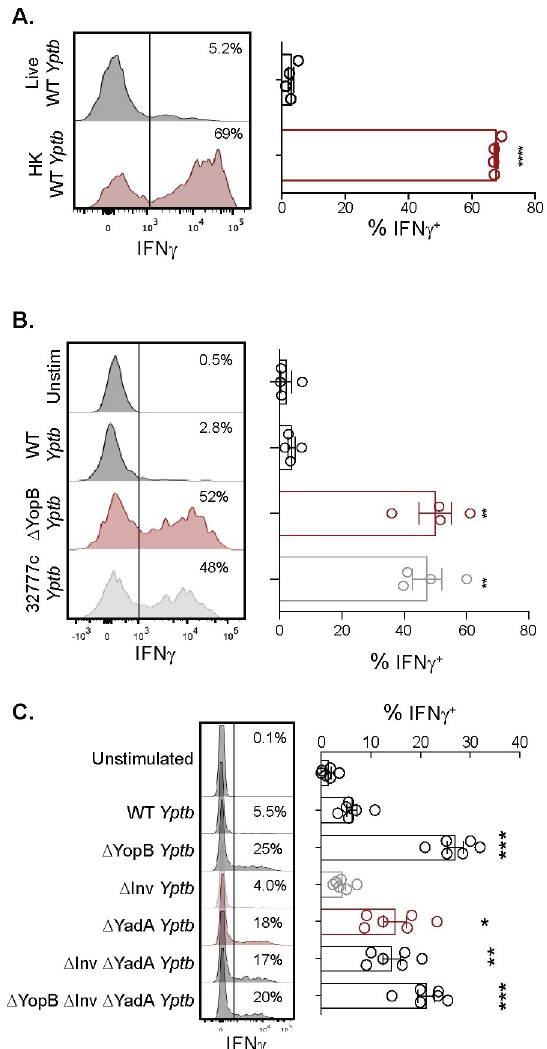
Fig 1. Y . pseudotuberculosis inhibition of V γ 1.1/2 - CD44 hi CD27 - γδ T cell function is YopB- and YadA- dependent. MLN cell suspensions from L . monocytogenes infected Balb/c mice were left unstimulated or stimulated with 10 MOI of the indicated Y . pseudotuberculosis for 24 hours. Antibiotics were given 2 hours post-stimulation and brefeldin A was added for the last 5 hours of stimulation. V γ 1.1/2 - CD44 hi CD27 - γδ T cells were analyzed for IFN γ production. Representative histograms are displayed. ( A ) Cells were stimulated with live or heat-killed (HK) wild-type (WT) Y . pseudotuberculosis . The graph depicts the mean ± SEM and represents at least two independent experiments with 4 mice/group/experiment. ( B ) Cells were stimulated with live WT, Δ YopB, or 32777c Y . pseudotuberculosis . The graph depicts the mean ± SEM and represents at least two independent experiments with 4 mice/group/experiment. ( C ) Cells were stimulated with WT, Δ YopB, Δ YadA, Δ Inv, Δ Inv Δ YadA, or Δ YopB Δ Inv Δ YadA Y . pseudotuberculosis . The graph depicts the mean ± SEM pooled from two independent experiments with 3 mice/group/experiment. ��� p < 0.0001, �� p < 0.01, and � p < 0.05. An unpaired t-test was used for ( A ) and a repeated measures one-way ANOVA was used for ( B ) and ( C ). Experimental groups were compared to live WT Y . pseudotuberculosis in ( A ) and WT Y . pseudotuberculosis in ( B ) and ( C